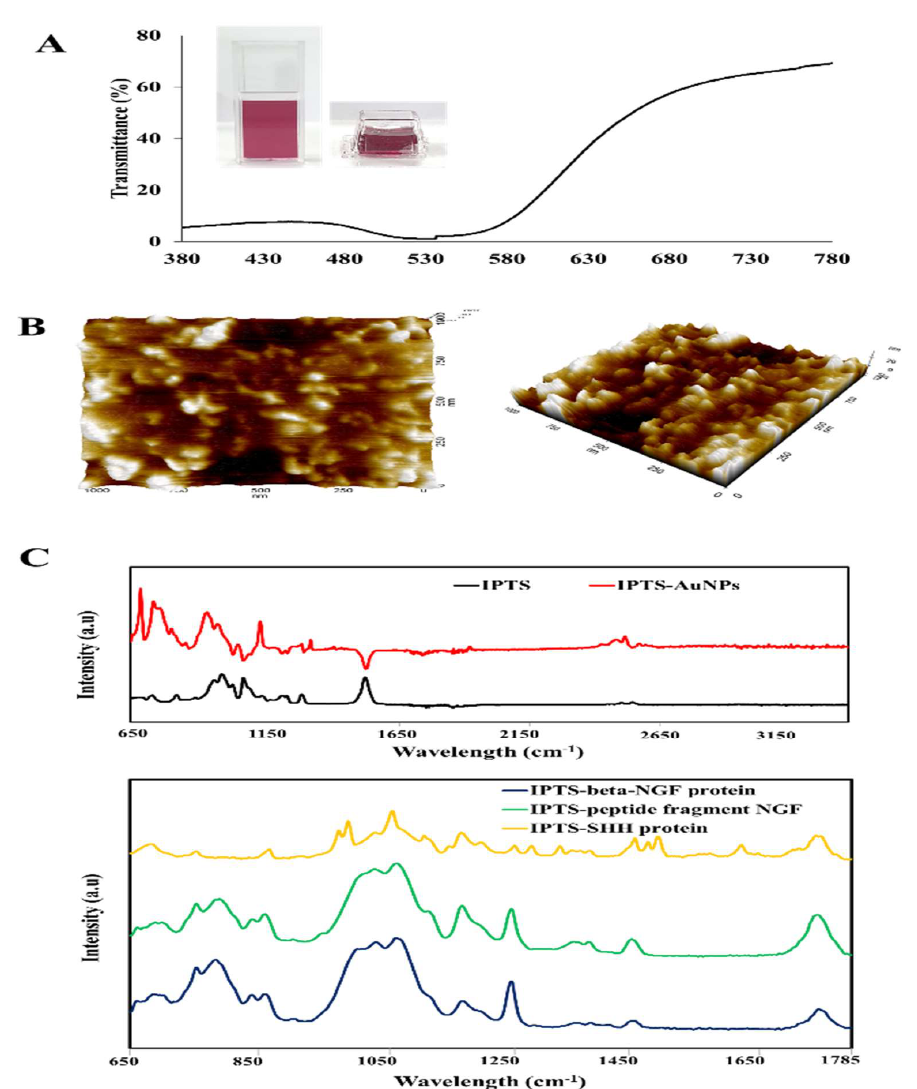
Figure 3. Characteristics of a printed industrial polylactic acid (PLA) three-dimensional scaffold (IPTS) coated with gold nanoparticles (Au-NPs), nerve growth factor (NGF) protein, NGF peptide fragments, or sonic hedgehog (SHH) protein. ( A ) Ultraviolet-visible spectroscopy of Au-NPs in solution. ( B ) Atomic force microscope image (1 µ m 3 ) showing the surface roughness of IPTS-Au- NPs. ( C ) Fourier transform infrared spectroscopy of non-coated IPTS and IPTS coated with Au-NPs, beta-NGF protein, NGF peptide fragments, and SHH